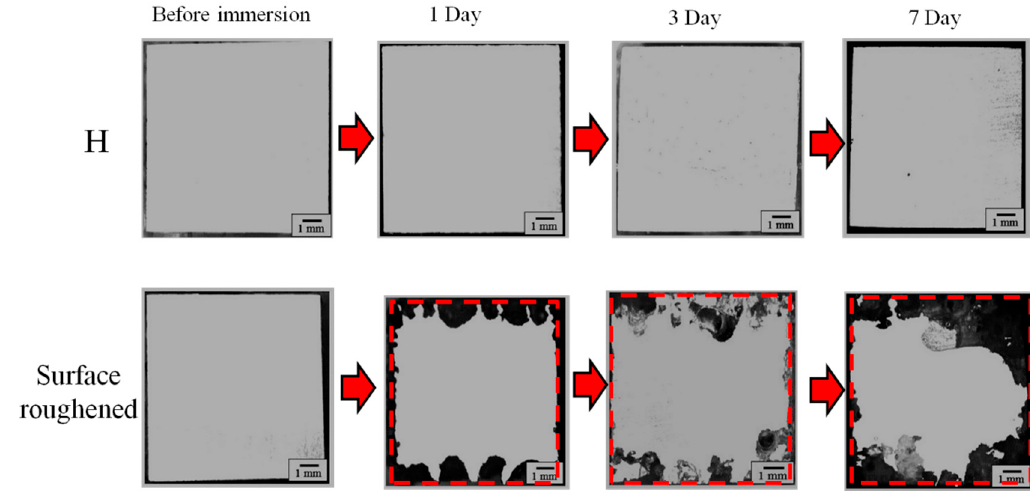
Figure 16. Cross-sectional observation of roughened surface during immersion test.